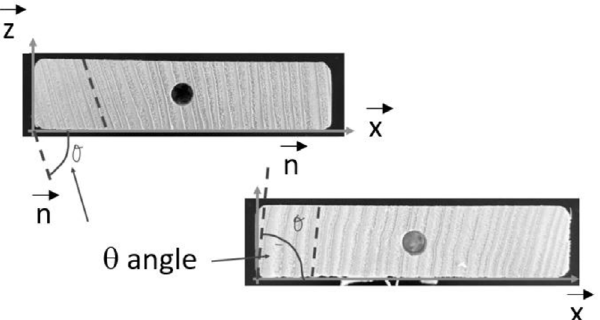
Fig. 4. Measure of the angle u of the wood fi bers orientation along the n-axis (circumferential direction represented in dashed line) with respect to the x-axis for two different wood specimens.